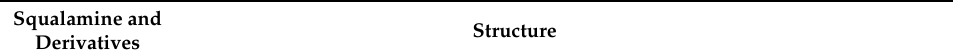
Table 1. Structure and biological activity of squalamine and its derivatives.